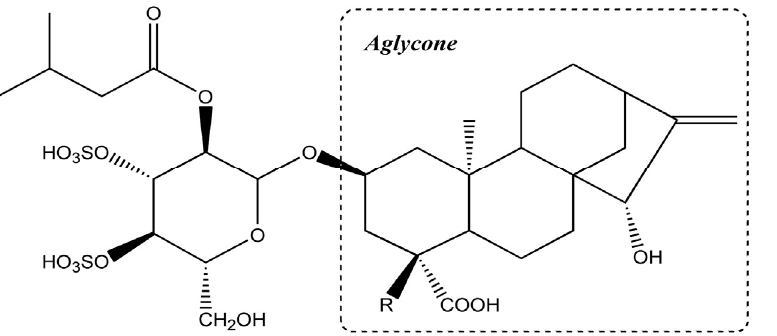
Figure 1. The chemical structures of atractyloside (R = H) and carboxyatractyloside (R =